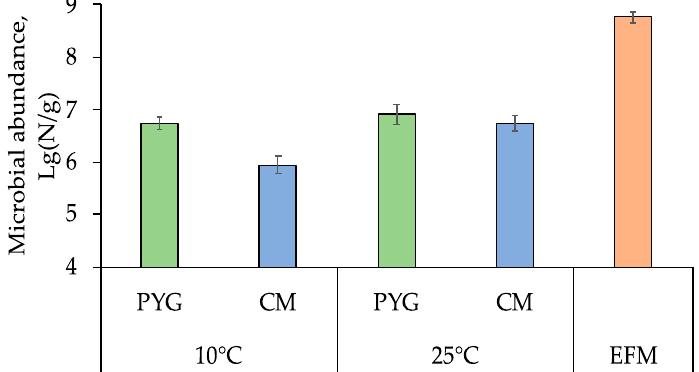
Figure 1. Total prokaryotic cells count obtained by epifluorescent microscopy (EFM) and culturable bacteria count on peptone-yeast-glucose (PYG) and Czapek modified (CM) media in the examined soil sample. Error bars are within the standard deviation, p < 0.05.